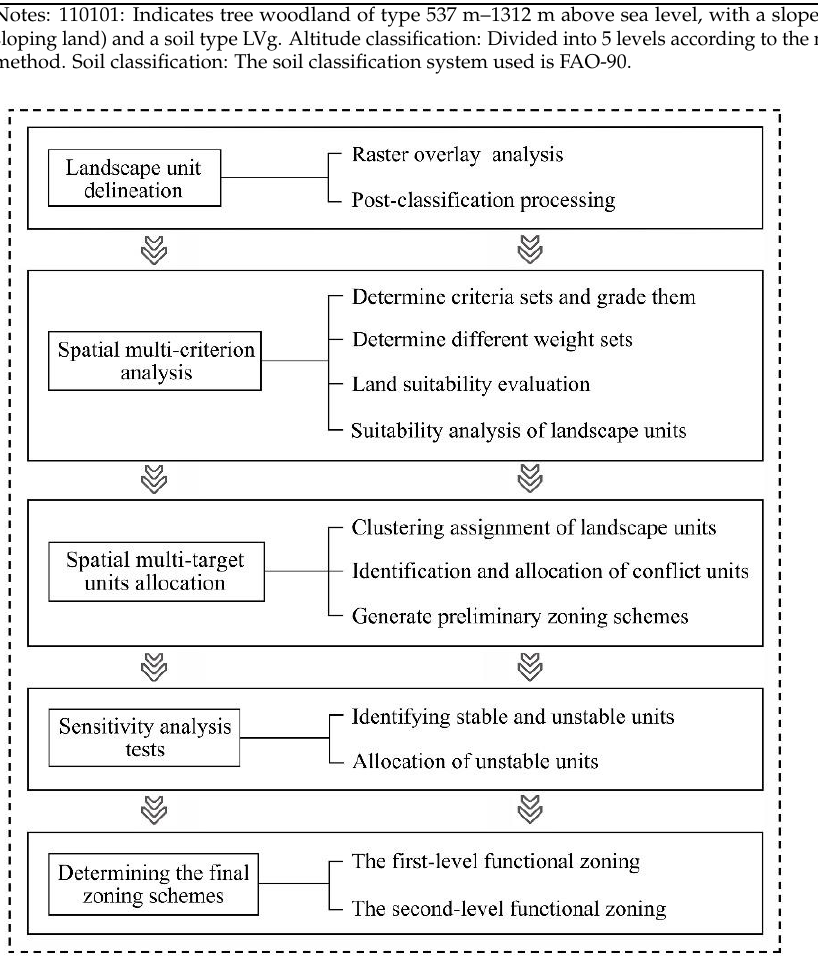
Figure 2. The technical flowchart of this